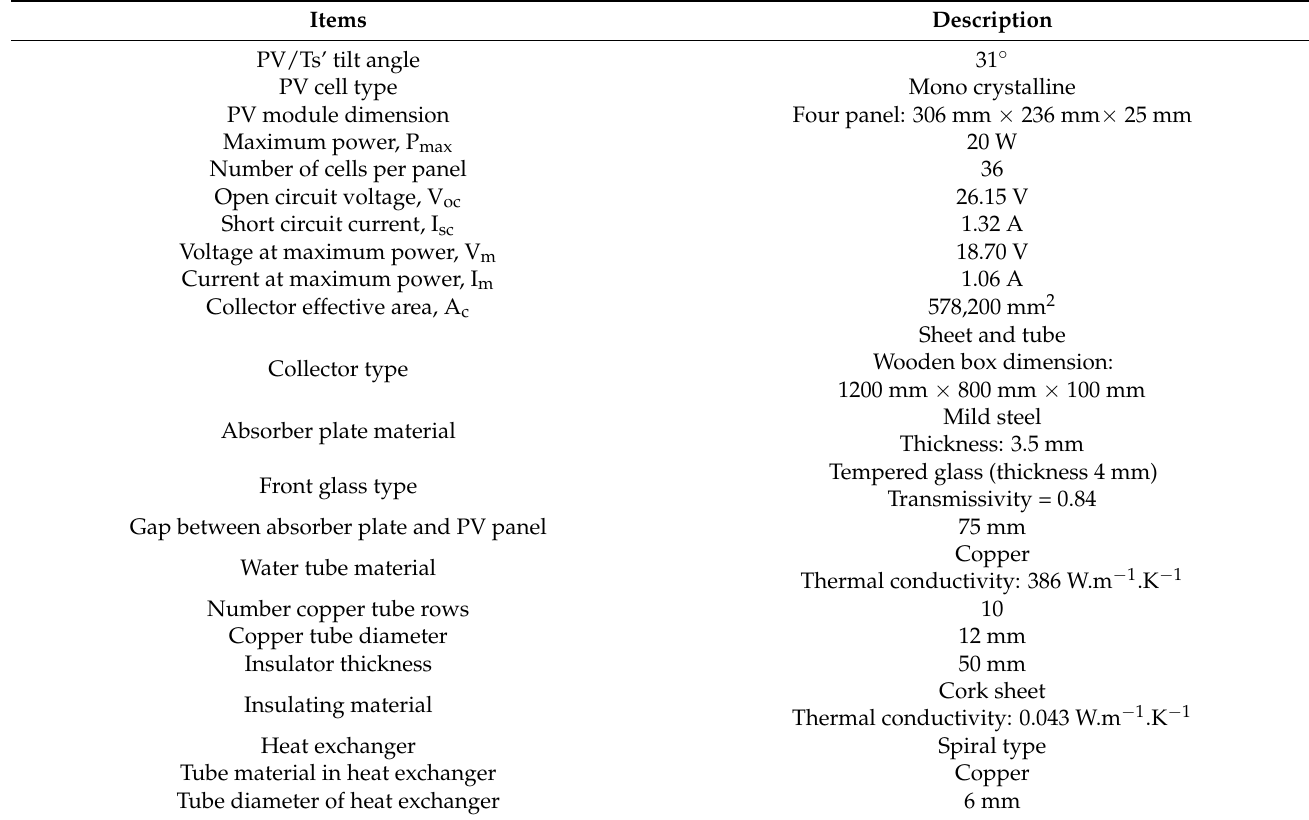
Table 1. Specification of the experimental